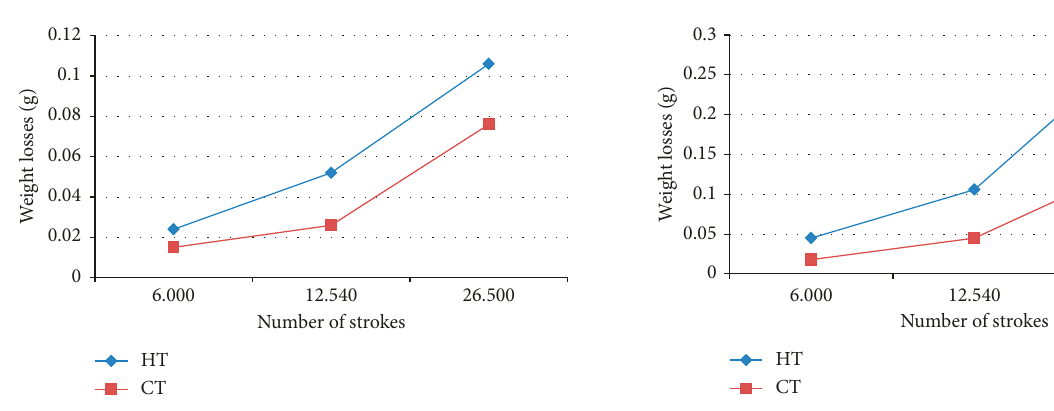
Figure 8: Weight loss and number of strokes (circular punch Ø6.2 × 100mm in diameter).